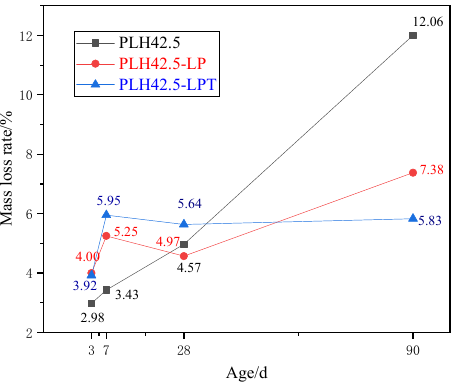
Figure 6. Mass loss rate of the cured pastes in the temperature range 100–400 °C. The SEM images of PLH42.5, PLH42.5-LP, and PLH42.5-LPT cured for 3, 28, or 90